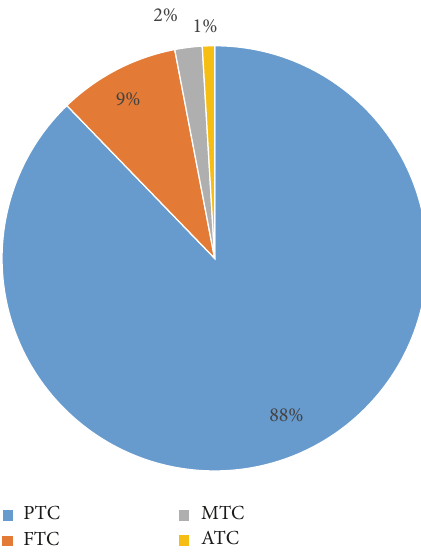
Figure 1: Prevalence of Papillary Thyroid Cancer in SEER 13 cohort. PTC: papillary thyroid cancer, FTC: follicular thyroid cancer, MTC: medullary thyroid cancer, and ATC: anaplastic thyroid